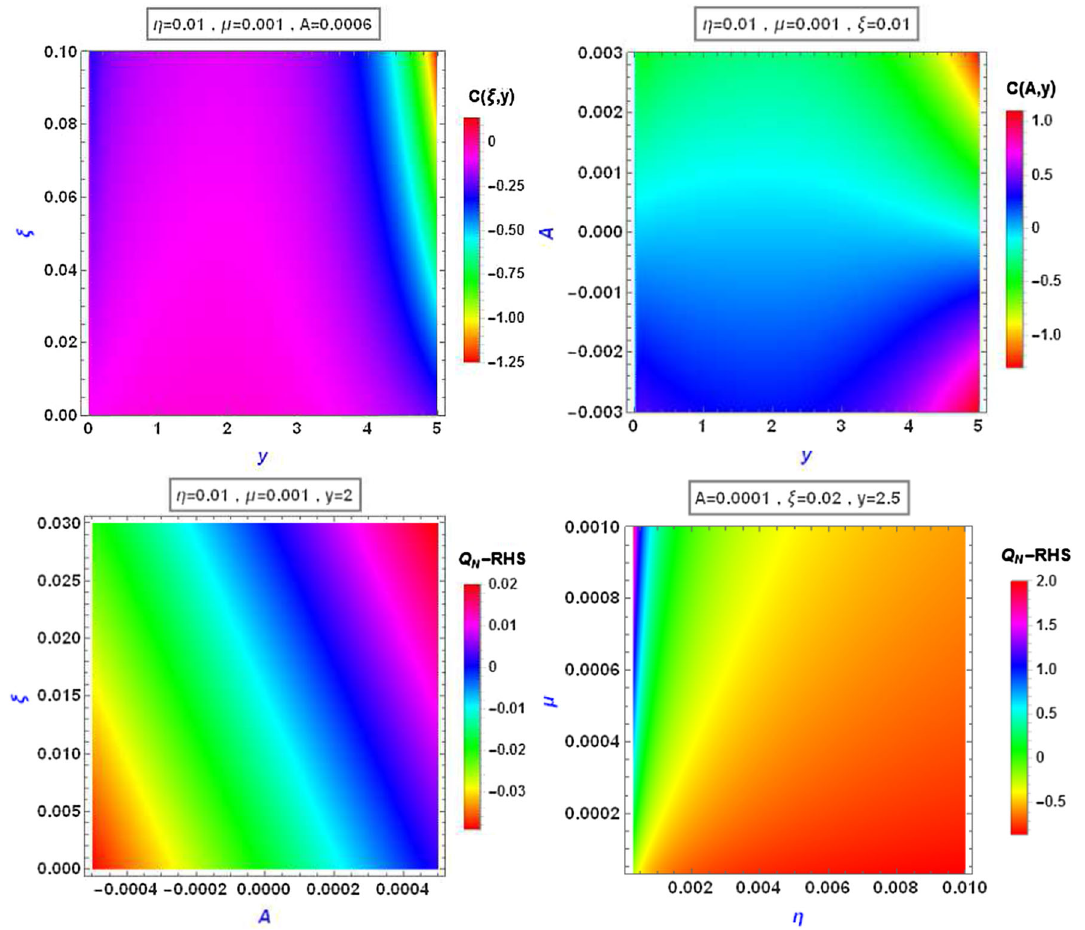
Fig. 2 The correction term C and the Toomre’s criterion in EMSG for various values of the model parameters. Note that, the Toomre’s criterion of Eq. (135) is written here as Q N − RHS . Whenever this expression is positive, the stability condition will be held. Furthermore, we take Γ =